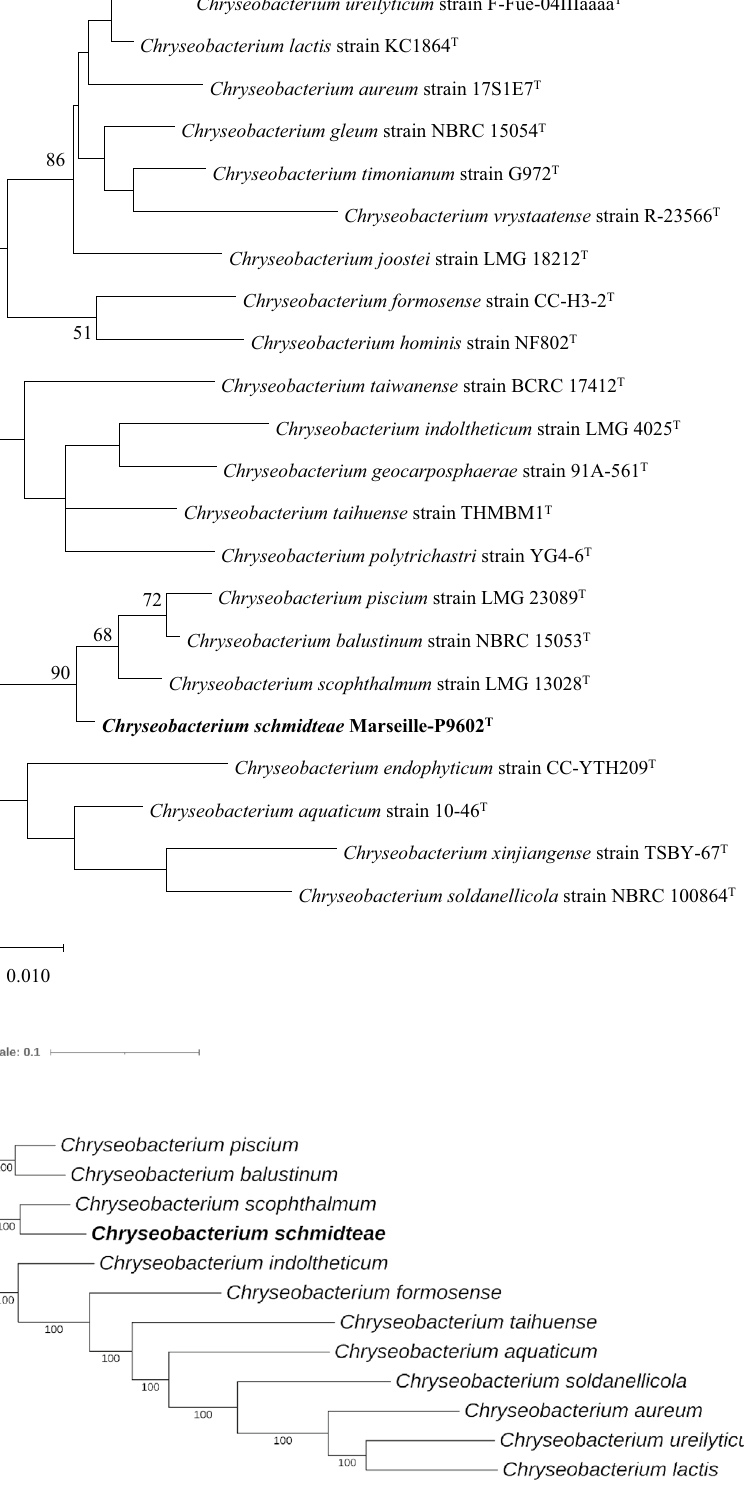
Figure 1. Phylogenetic tree and Core-genome. ( A ) Phylogenetic tree based on 16S rRNA sequence comparison highlighting the position of Marseille-P9602 strain relative to other closely related species. Only bootstrap values ≥ 50% were shown. ( B ) Core-genome-based phylogenetic relationships of Marseille-P9602 strain relative to other closely related